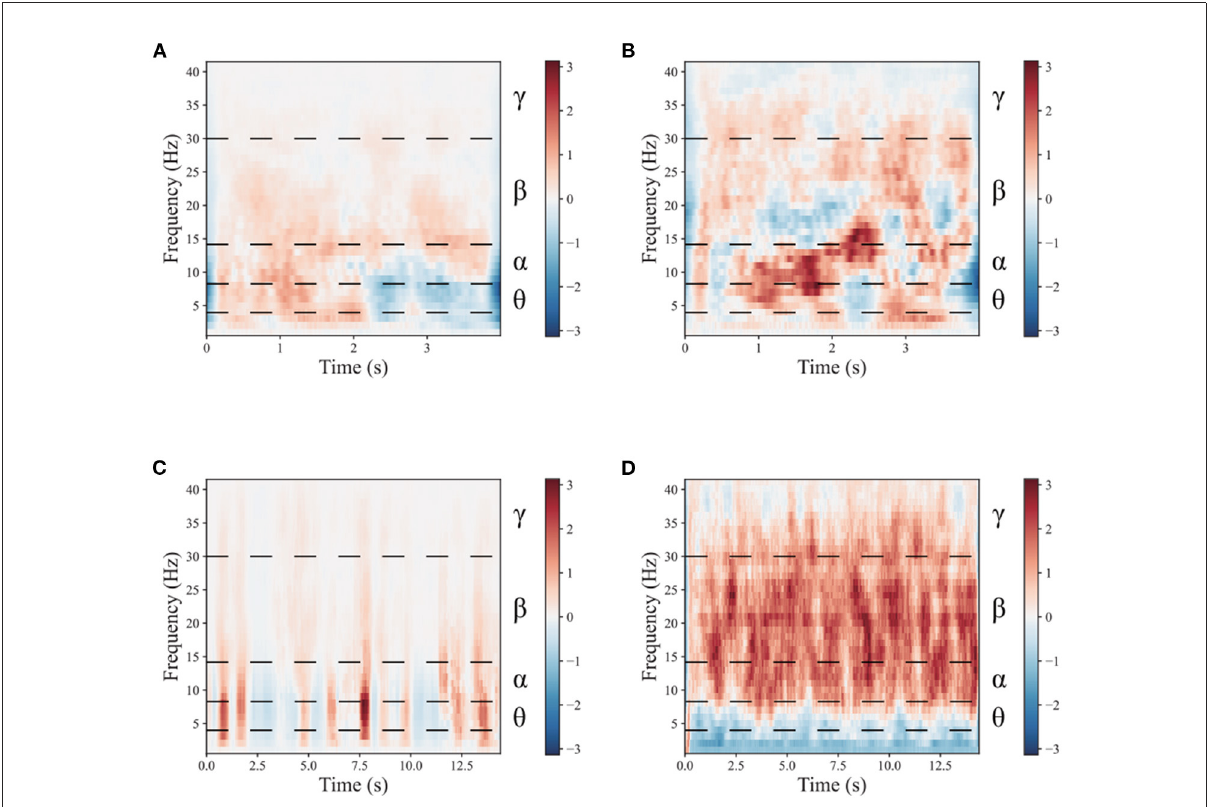
FIGURE4 The mean time-frequency of the lower limb movement imagery with and without stimulation in CPZ electrodes from subject A09 of the in-house dataset. (A) The rest state imagery without stimulation. (B) Lower limb movement imagery without stimulation. (C) The rest state imagery with stimulation. (D) Lower limb movement imagery with